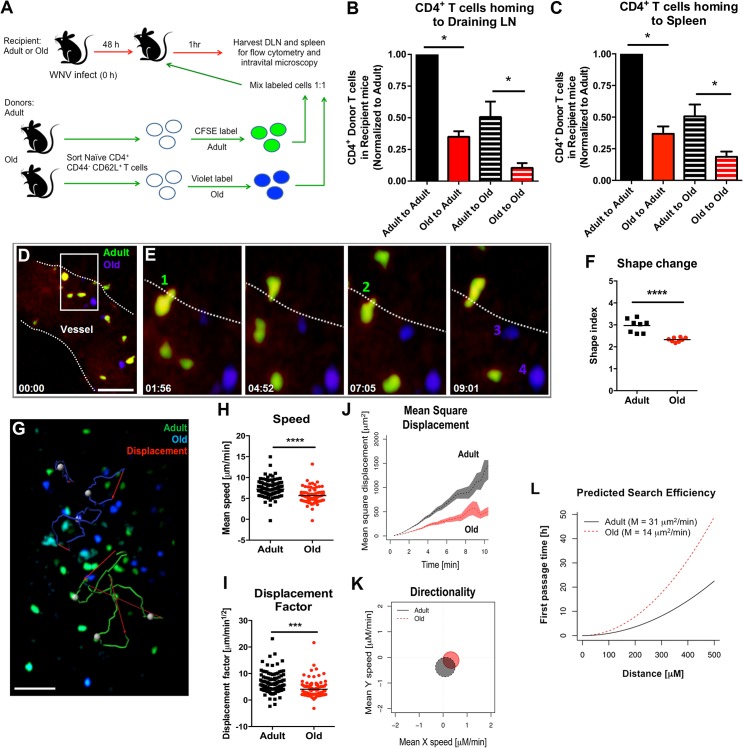
Defects in migration of naïve CD4+ T cells from old mice into inflamed LN.
A. Scheme of adoptive transfer studies. 2 x 106 FACS-sorted naïve (CD44- CD62L+) CD4+ T cells from adult or old mice were differentially labeled with fluorescent dyes, mixed in a 1:1 ratio, and transferred to recipient adult or old mice that had been infected with WNV-KUN 48 hours earlier via a subcutaneous route. B-C. One hour later, draining popliteal LN (B) and spleen (C) were harvested. Cells were counted and the frequency of adult and old donor cells was determined by flow cytometry. In each tissue, the data was normalized to the levels of adult donor cells in the adult recipient organ and is a composite of four independent experiments. Asterisks indicate statistical significance (*, P < 0.05; Mann-Whitney test). D-E. Time-lapse two-photon intravital imaging of diapedesis of labeled donor naïve CD4+ T cells (adult = green; old = blue) in the HEV from the DLN of a recipient WNV-KUN-infected mouse. Images are individual frames from a continuous time-lapse movie (see S1 and S2 Movies). Relative time is displayed in min:sec. Panel D shows a picture of a Q-dot labeled vessel in a LN with multiple old (blue) and adult (green) CD4+ T cells adhering to the endothelium. The white dotted line is drawn to highlight the edge of the vessel lumen. The white box shows a zoomed in view of an extravasation "hot spot" that is then presented as a 4 time-lapse images in panel E. Two T cells (cells 1 and 2) from adult mice are shown undergoing diapedesis, whereas two representative T cells (cells 3 and 4) from old mice remain in the lumen over the same time frame. F. Cellular deformation of donor naïve CD4+ T cells in the HEV from the DLN of a recipient WNV-KUN-infected mouse as determined by analysis of two-photon microscopic images. G. Time-lapse two-photon imaging of movement of labeled donor naïve CD4+ T cells (adult = green; old = blue) in explanted DLN of a recipient WNV-KUN-infected mouse (see S3 Movie). The figure presents representative cell tracking for adult and old CD4+ T cells followed by evaluation of displacement. White opaque dots represent cells with tracked paths (green or blue). Red arrow indicates cell displacement. Scale bar (white): 40 μm. H-L. Analysis of movement parameters of adult and old donor naïve CD4+ T cells in explanted LN 6 to 8 hours post-transfer to recipient mice infected with WNV-KUN 48 hours earlier. Individual cells were tracked and (H) speed (μM/min), (I) cell displacement factor (μm/min1/2), (J) mean square cell displacement over time (μm2), (K) randomness of migration (Hotelling’s test of directionality) and (L) the predicted time of search efficiency for antigen. For panel K, the migration directionality was of a small magnitude, and no significant difference was observed between the cells from adult and old mice. For panel L, to judge the impact that the observed motility defects of old T cells would have on their ability to search antigen in DLN, we used a mathematical model [30] to predict the time needed by adult and old T cells to first reach increasingly distant locations (first passage time). The first passage time is proportional to the motility coefficient, which we estimated from the mean square displacement data. The predicted time to reach a location 500 μm away is ~20 hours for adult T cells, but ~50 hours for old T cells. The data in F, H and I are shown as a scatter plot and reflects three independent experiments. Asterisks indicate statistical significance (***, P < 0.001, ****, P < 0.0001; Mann-Whitney test).